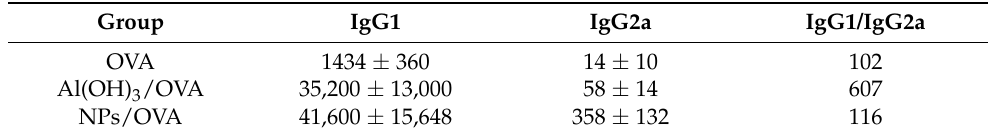
Table 2. Endpoint titer of OVA-specific IgG1, IgG2a and IgG1/IgG2a ratio determined 21 days after immunization.